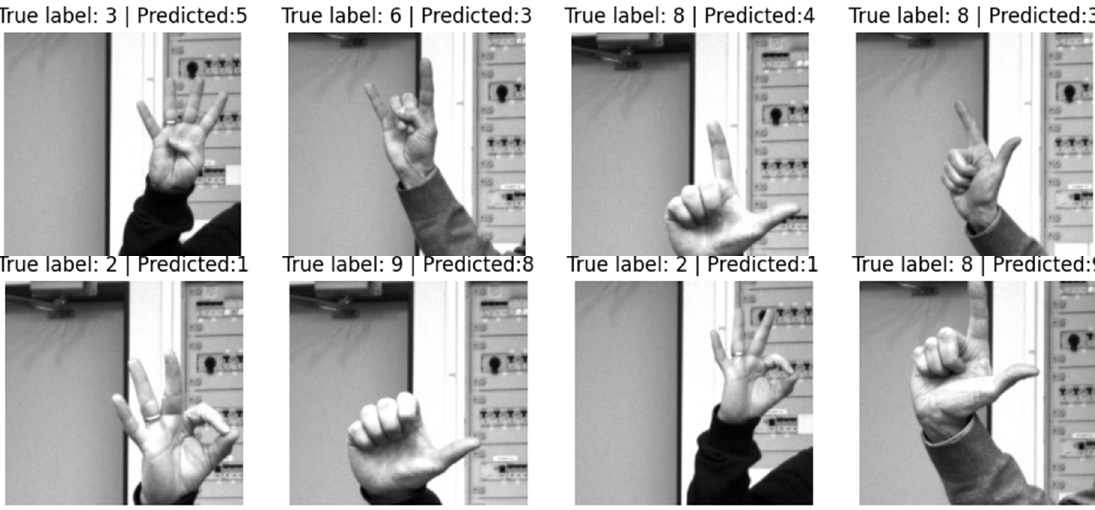
Figure 19. Examples of incorrectly classi fi ed